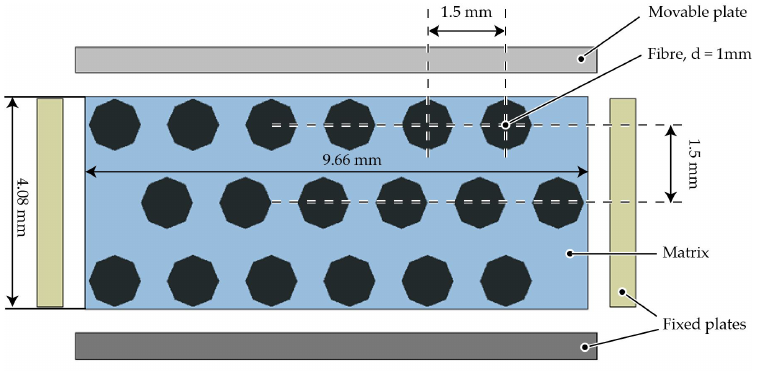
Figure 7. Geometric model setup for the collision